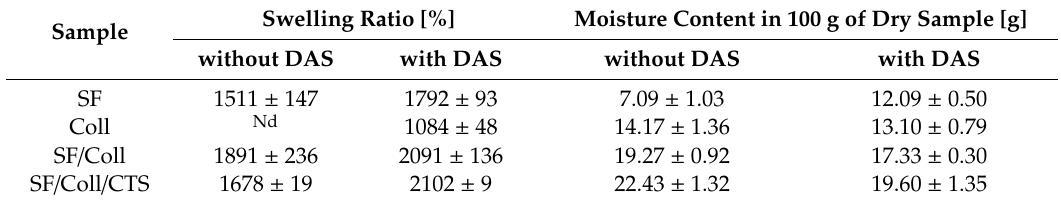
Table 2. Sca ff olds swelling ratio and moisture content after immersion in PBS for 1 h; Nd —not